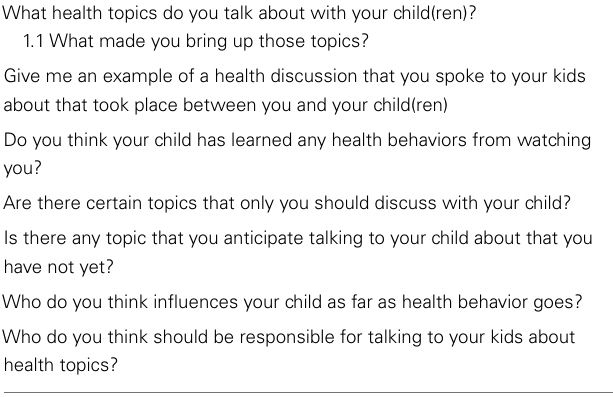
Table 2 | Select questions from semi-structured interview guide